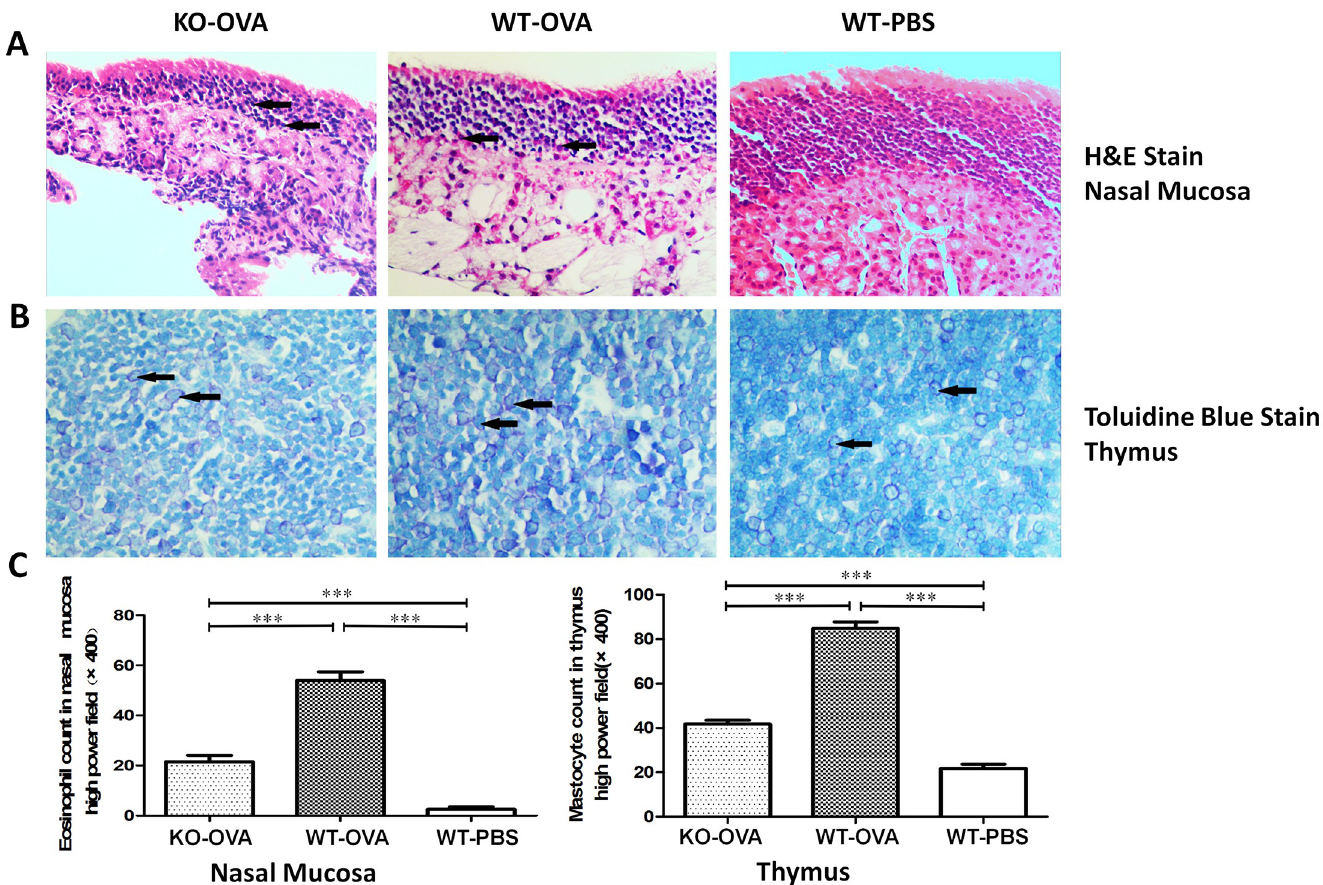
Fig 3. Histology of the nasal mucosal and thymus tissue, and the invasion of eosinophilic granulocytes and mast cells. The panels in A show the H&E (pink) staining of the mouse nasal mucosal ( × 400) tissues from different groups. The panels in B show the toluidine blue staining of the mouse thymus ( × 400) samples from different groups. The panels in C show the numbers of eosinophilic granulocytes in the nasal mucosal tissues and mast cells in the thymus tissue ( ��� P < 0.001, �� P < 0.01, � P < 0.05). Arrows indicate cells with highly positive staining.